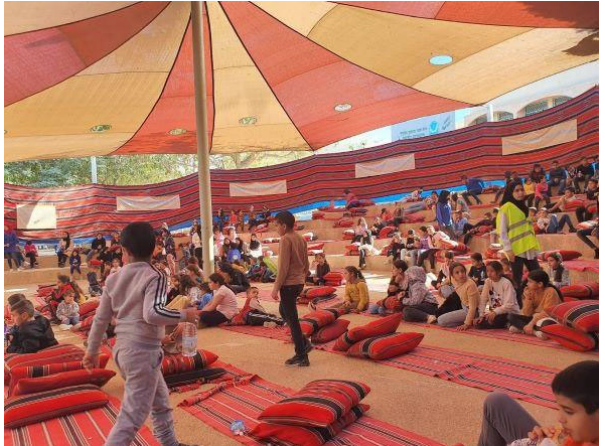
Figure 13. Kuseifa Tent, 2021. Adhering to local traditional hospitality tents, it was used as a communal gathering place. Photographed by Dan Farberoff. Image courtesy of the artist.